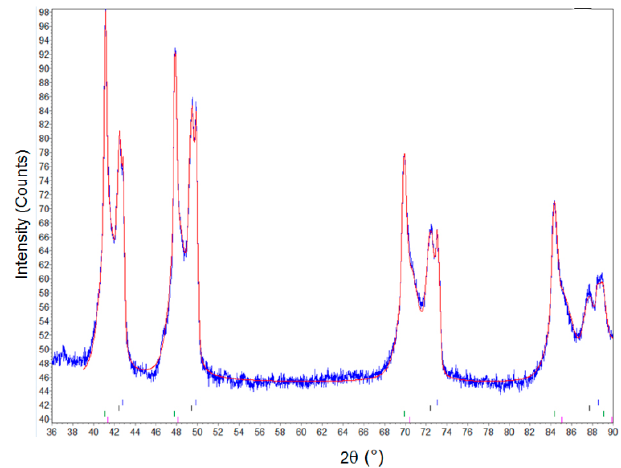
Figure 2. Comparison between the measured and predicted XRD pattern.